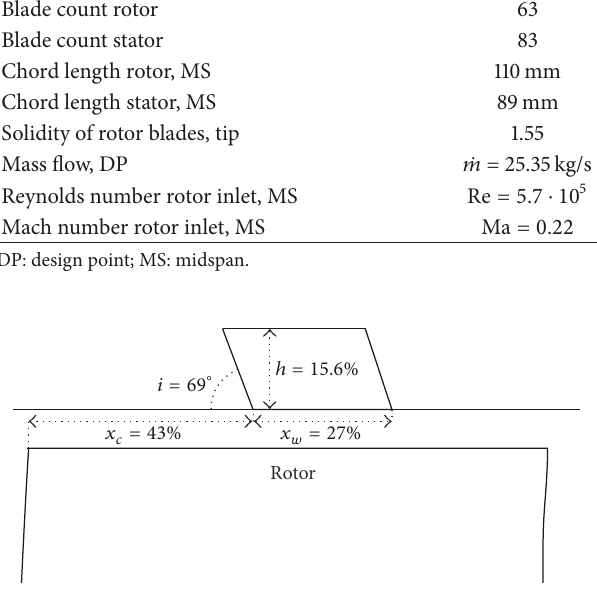
Figure 2: Geometry of circumferential casing groove.